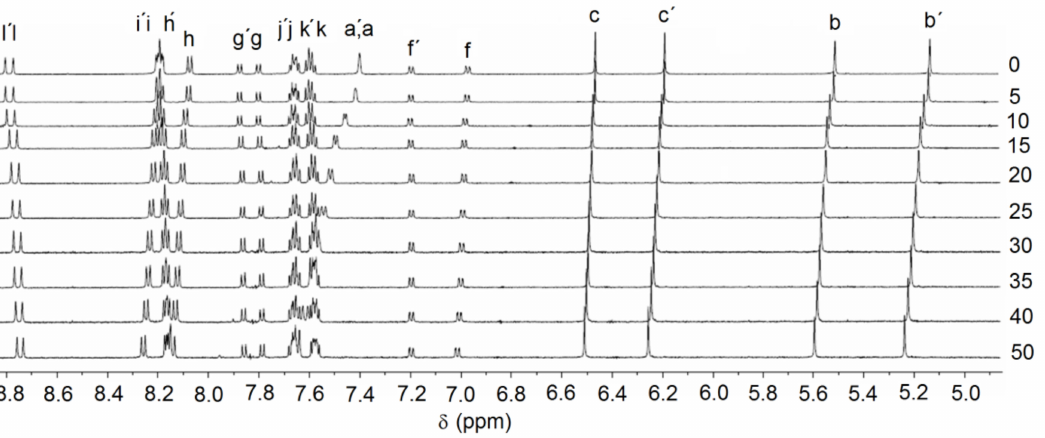
Figure 5. 1 H-NMR spectral changes observed in the receptor 5 2+ · 2PF 6 − in CD3CN/CD3OD (8/2, v / v ) during the addition from 0 (top) to 50 equiv. (bottom) of H 2 PO 4 −